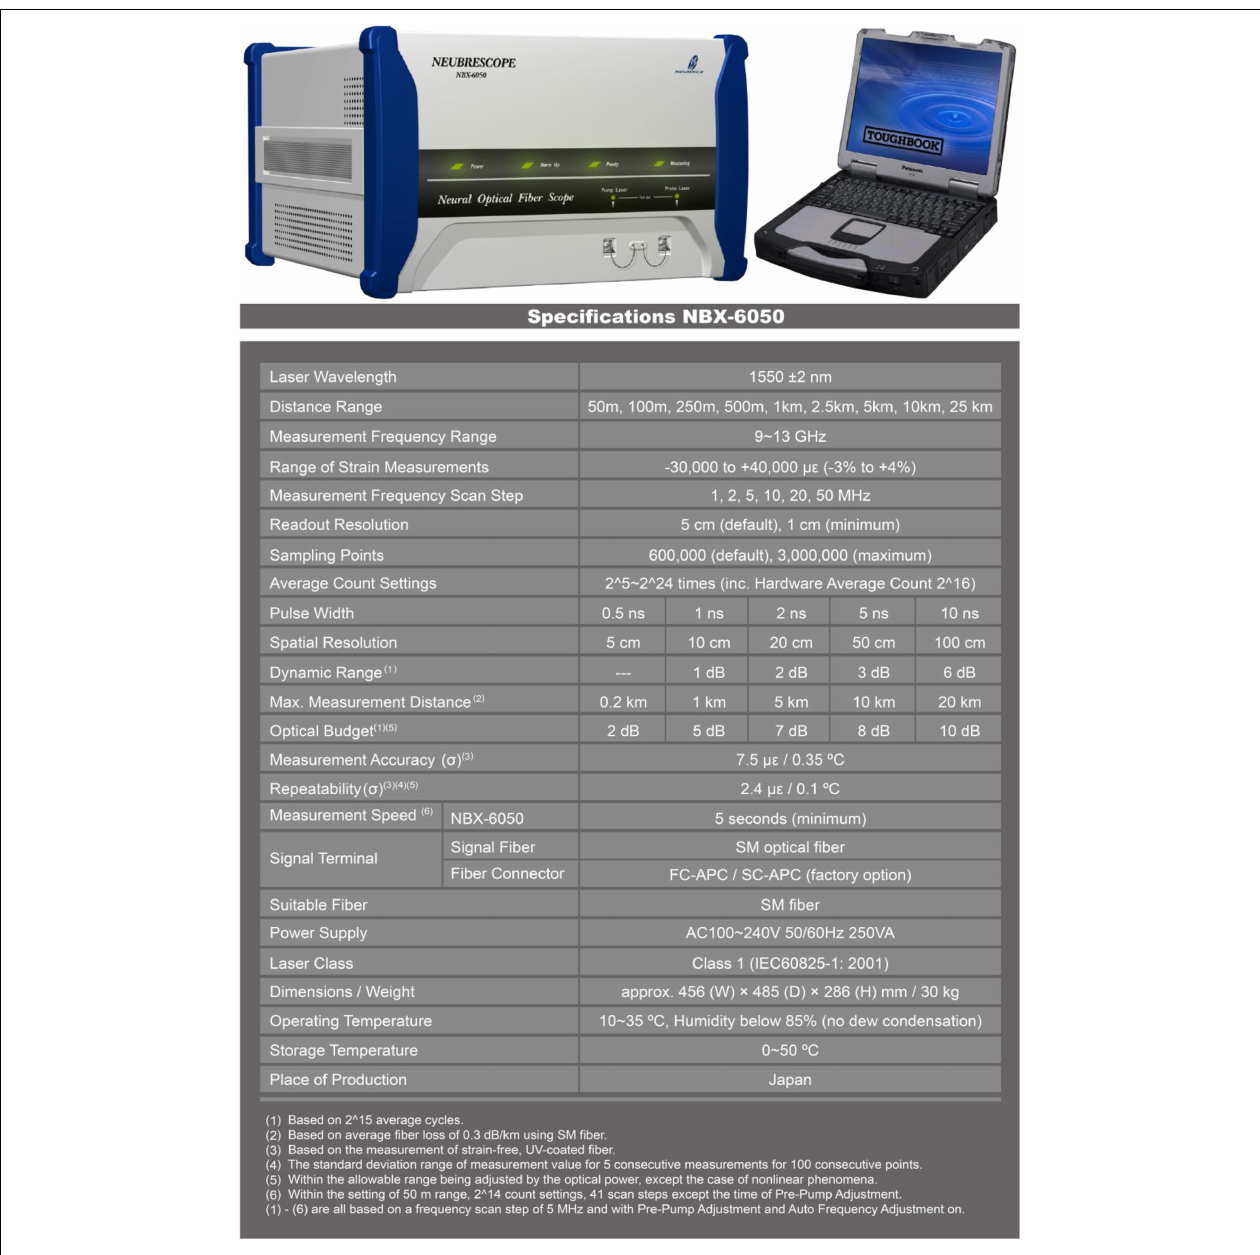
FIGURE 6 | The monitoring instrument NBX–6050 and its main parameter settings.